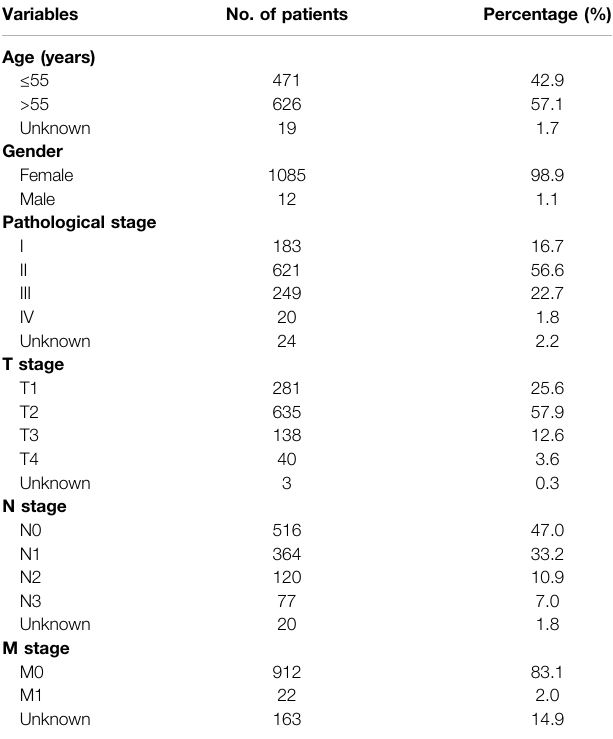
TABLE 1 | Clinical characteristics of patients with breast cancer. Variables